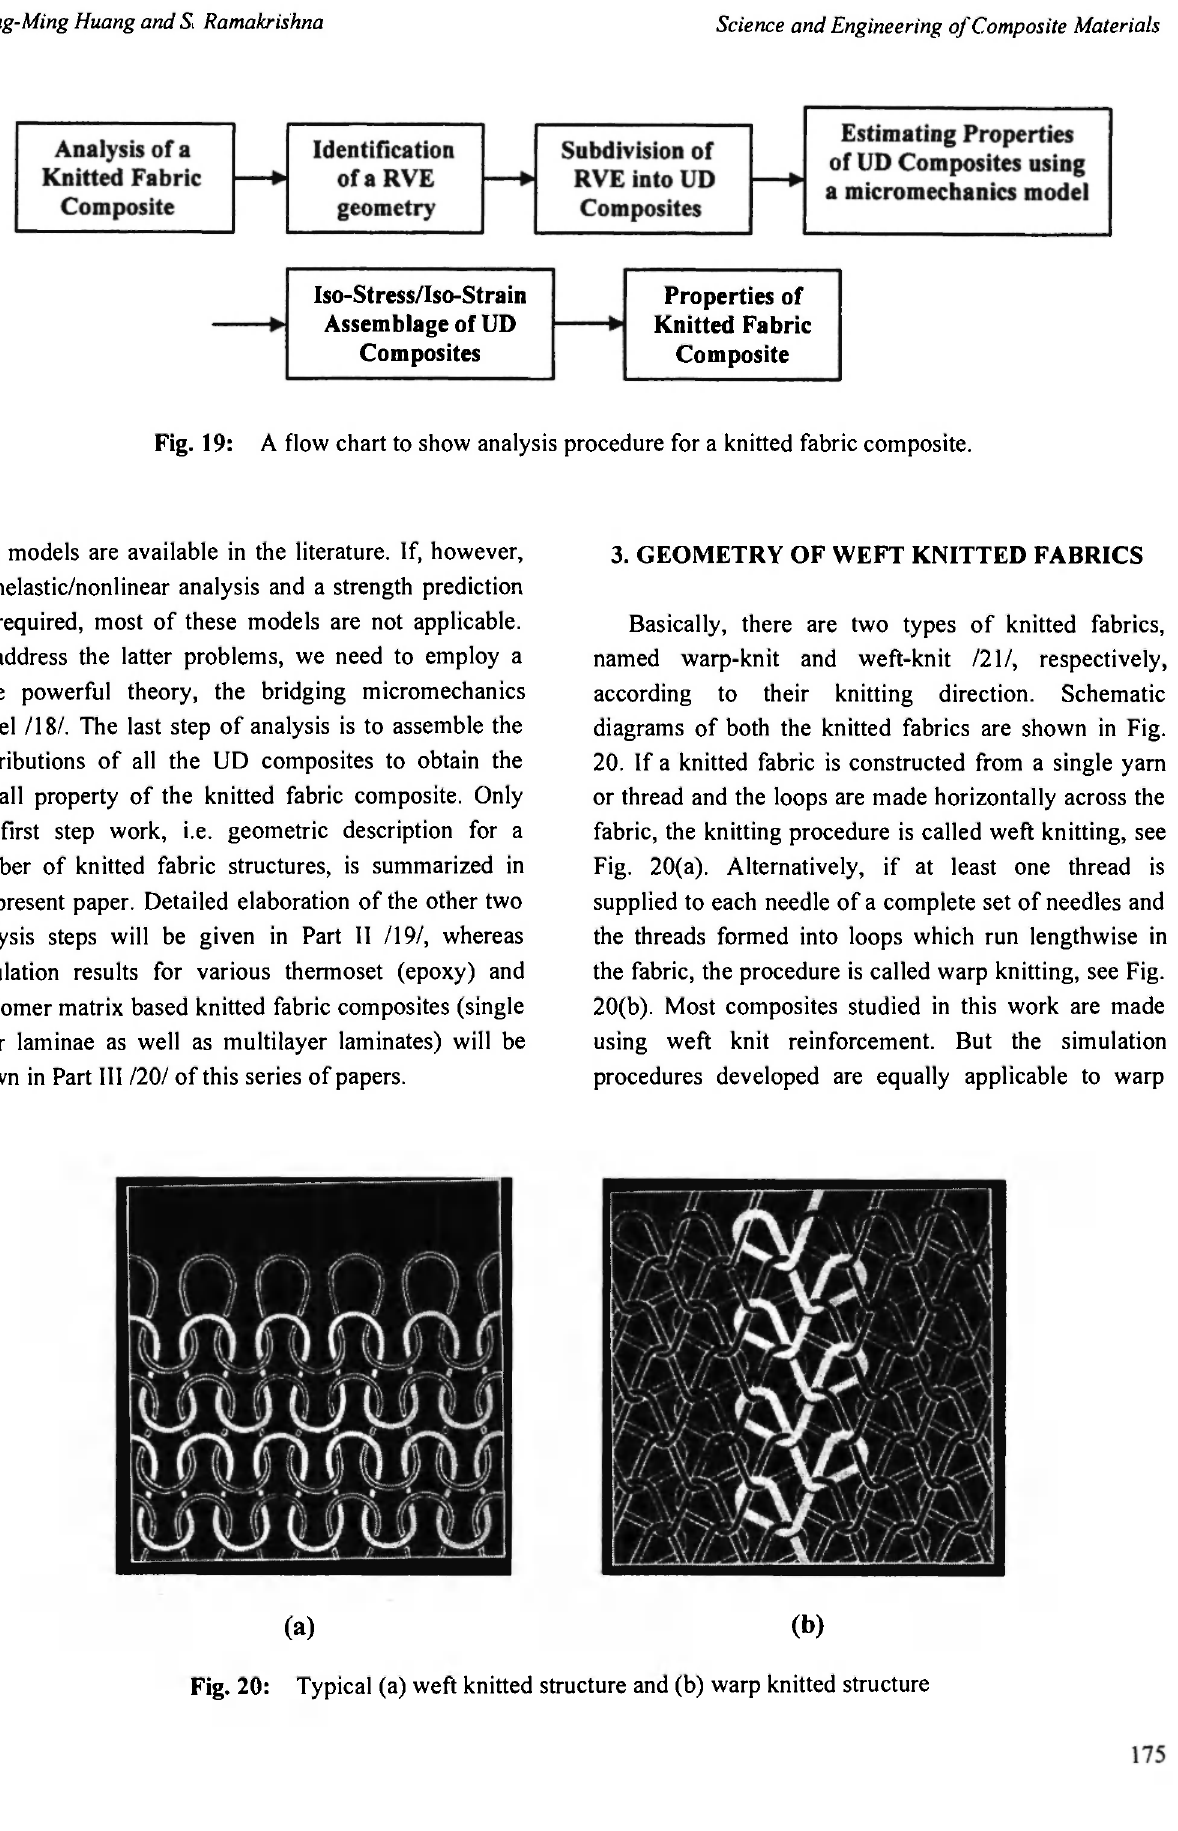
Fig. 20: Typical (a) weft knitted structure and (b) warp knitted